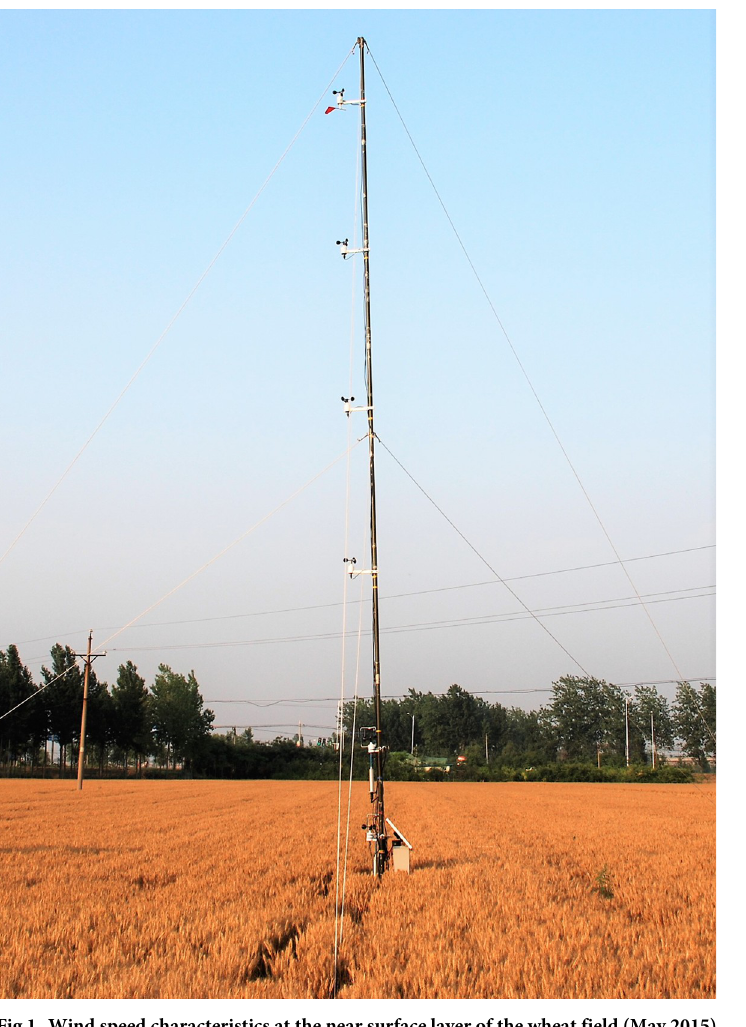
Fig 1. Wind speed characteristics at the near surface layer of the wheat field (May